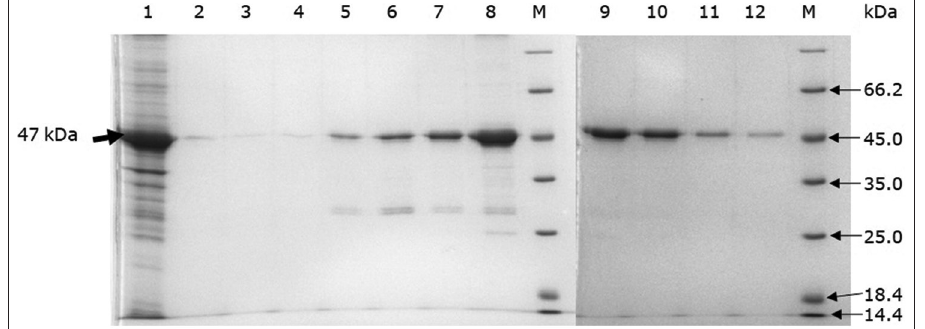
Figure-2: Sodium dodecyl sulfate-polyacrylamide gel electrophoresis of rP32Trx protein purified using metal affinity chromatography. Lane 1: Supernatant of the Escherichia coli BL21(DE3)/P32Trx after ultrasonication, Lane 2: Wash buffer, Lanes 3 and 4: 50 mM imidazole eluent, Lanes 5 and 6: 100 mM imidazole eluent, Lanes 7 and 8: 150 mM imidazole eluent, Lanes 9–12: 500 mM imidazole eluent, Lane M: Molecular weight markers (#26610, Thermo Fisher